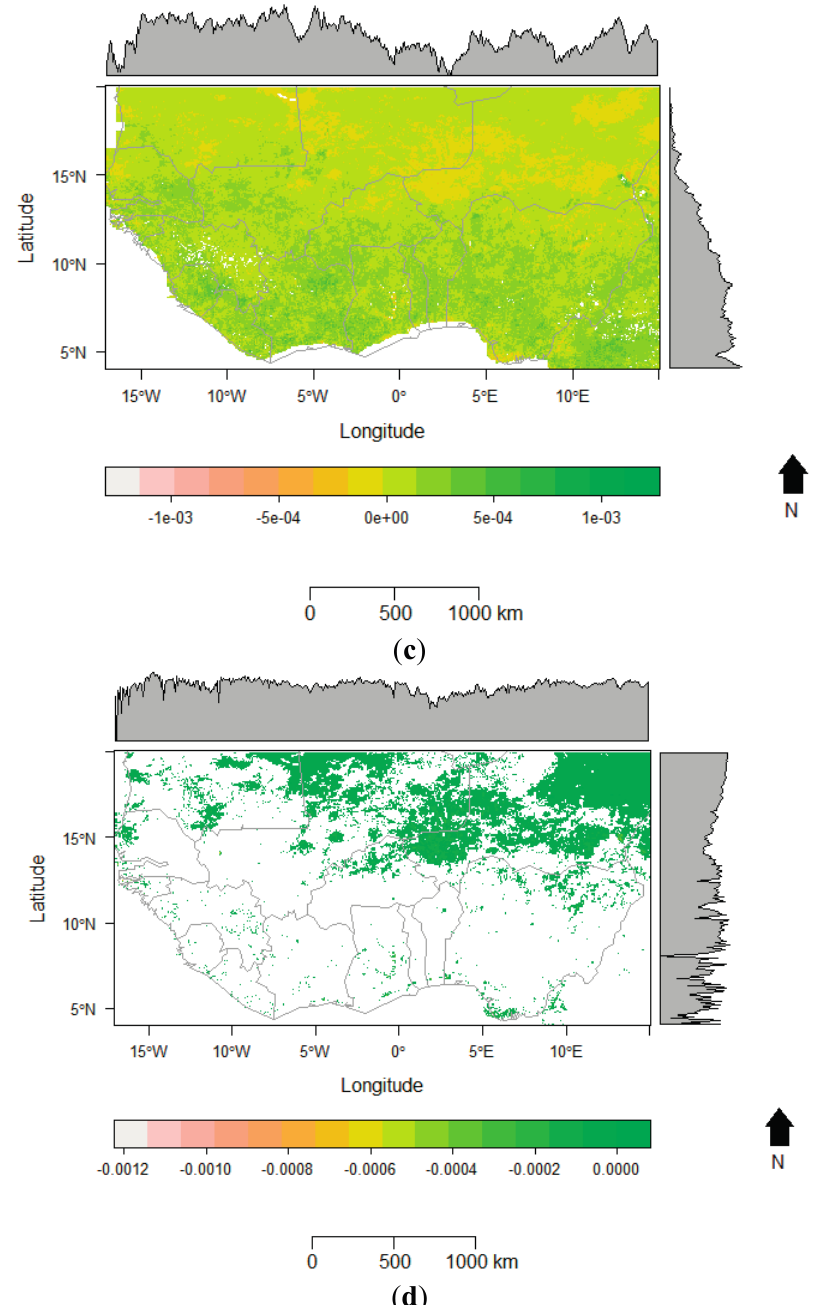
Figure 4. Spatial distribution slopes of the residuals of regressions of NDVI against time ( a ) from the RESTREND analysis using soil moisture and ( b ) areas with significant negative trends (95% confidence) ( c ) from the RESTREND analysis using rainfall ( d ) areas with significant negative trends (95% confidence). Negative values indicate land degradation in the study area between 1982 and 2012. White color indicates areas with non-significant